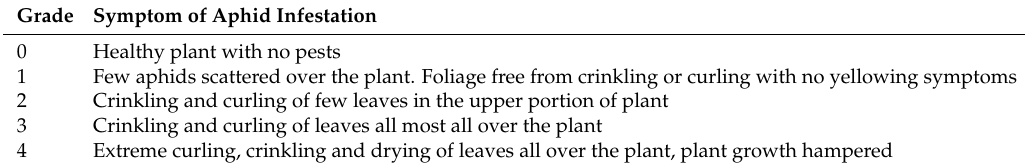
Table 2. Grading of cotton plants infested by